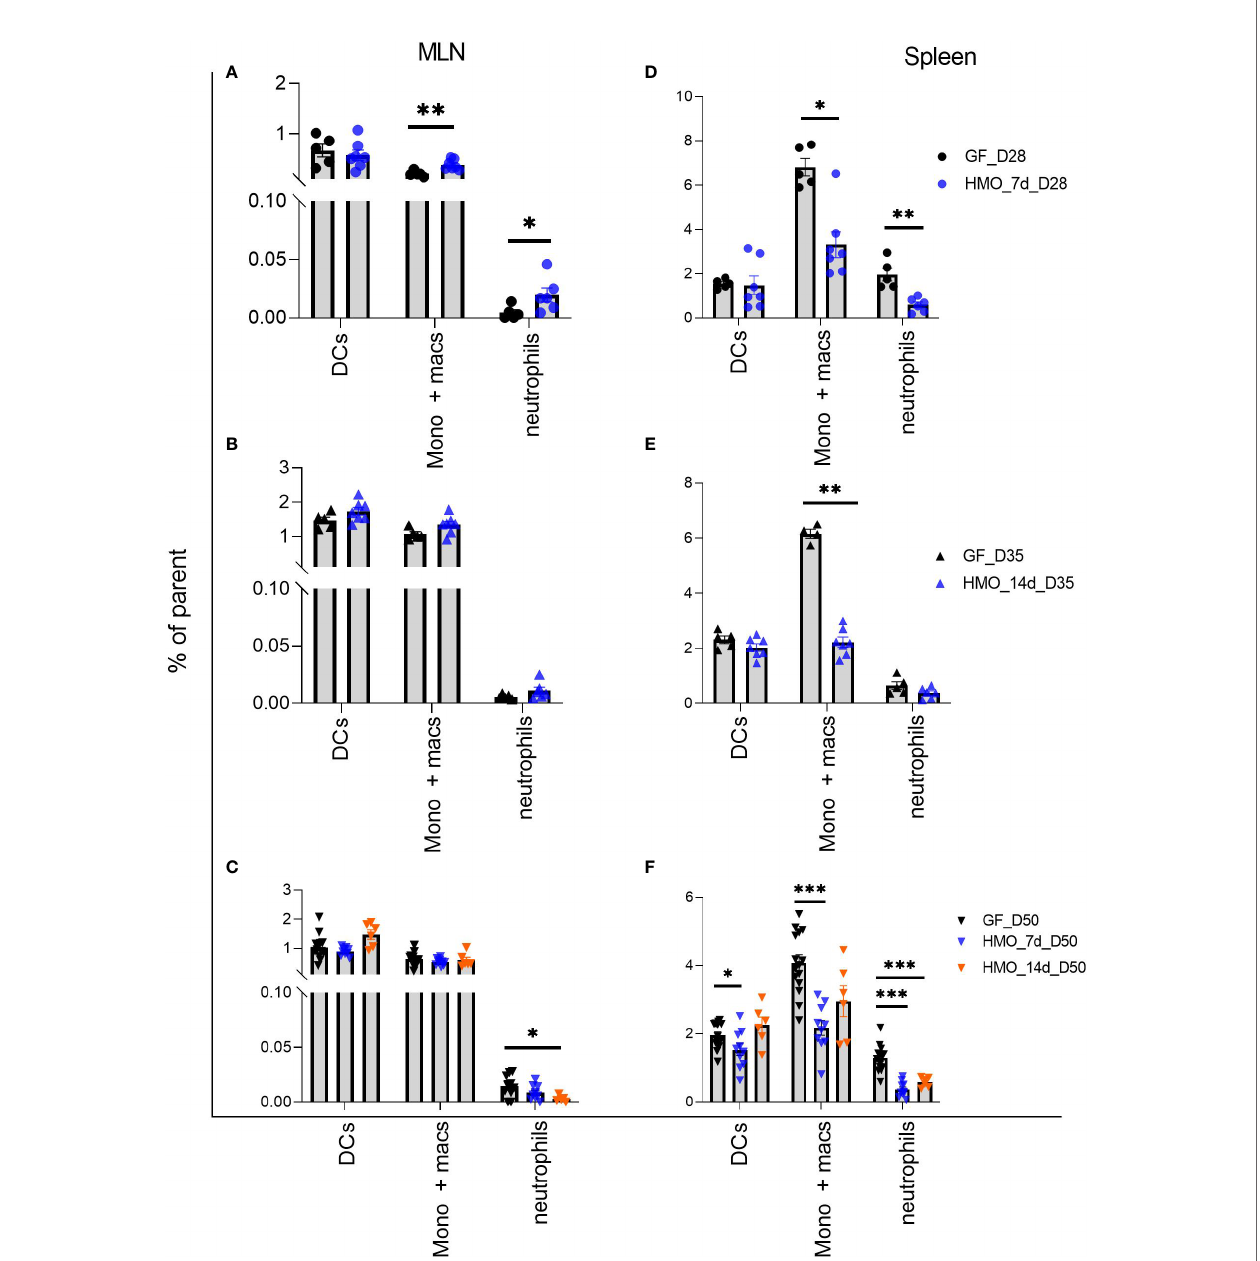
FIGURE 8 | Neutrophils (PMNs) (B220- NK 1.1- CD11b+ Ly6G+), Monocytes/Macrophages (B220- NK 1.1- Ly6G- CD11b+) and dendritic cells (B220- NK 1.1- CD11c+ MHC-II+) in MLN and spleen following HMO administration. (A – C) Myeloid cell composition in MLN. (D – F) Myeloid cells composition in spleen. Data are shown as the percentage of respective parent population ( Supplementary Figure 1C ). Each dot represents a mouse and data are shown as mean ± SEM. Statistical analysis was performed using Mann – Whitney test in GraphPad Prism Version 9.3.1 (www.graphpad.com). Statistical signi fi cance: *** p<0.001, **p<0.01, *p<0.05, ns, not signi fi cant. Groups: Control (GF_D28, GF_D35, and GF_D50) = GF Mice euthanized either at 28 days of age (n= 5; M=2, F=3) or 35 days of age (n= 5; M=2, F=3) or 50 days of age (n= 16; M=8, F=8) respectively; HMO_7d_D28 (n= 7; M=3, F=4) = GF mice that received 100 ul of HMO through 7 consecutive days and euthanized at 28 days of age; HMO_14d_D35 (n= 7; M=3, F=4) = GF mice that received 100 ul of HMO through 14 days and euthanized at 35 days of age; HMO_7d_D50 (n= 11; M=6, F=5) = GF mice that received 100 ul of HMO through 7 consecutive days and euthanized at 50 days of age; HMO_14d_D50 (n= 6; M=5, F=1) = GF mice that received 100 ul of HMO through 14 consecutive days and euthanized at 50 days of